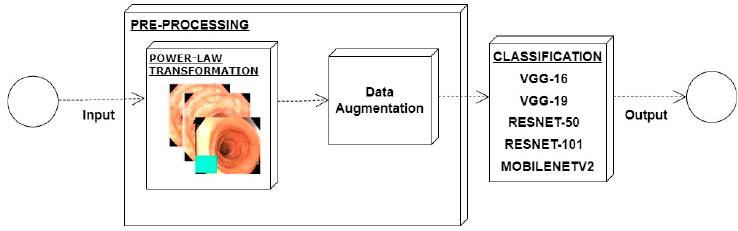
Figure 3. System architecture after applying power law